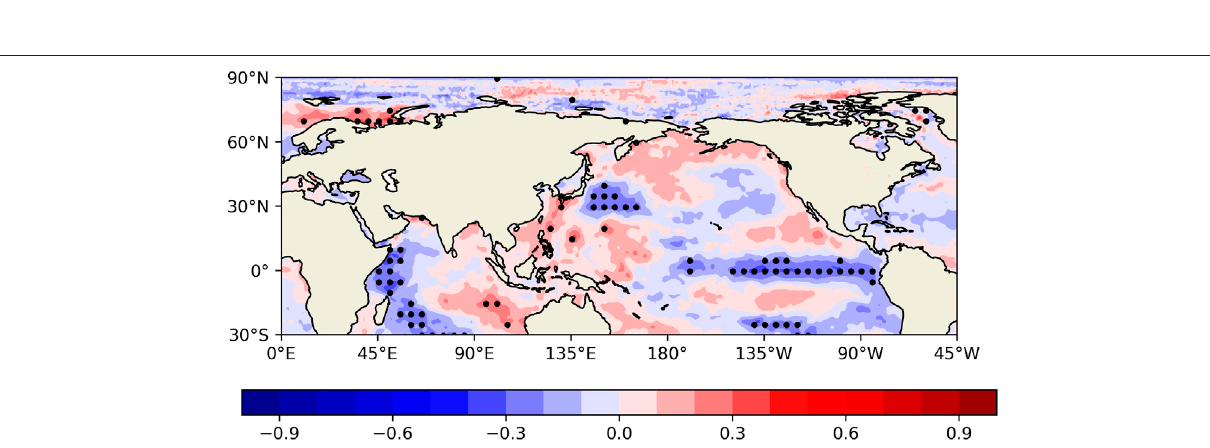
Frontiers in Earth Science |